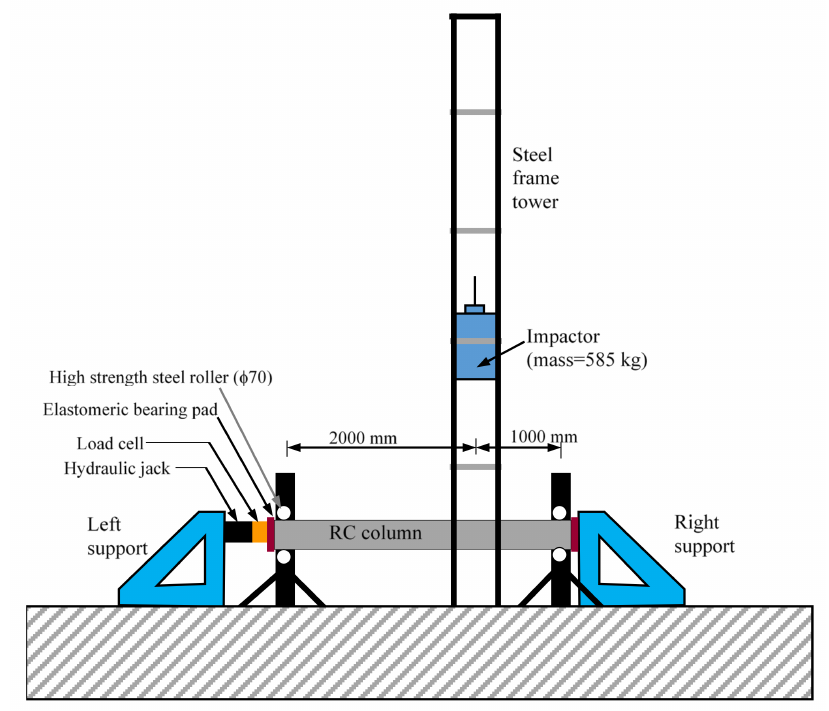
Figure 2. Schematic diagram of test setup for the drop weight impact on the RC column